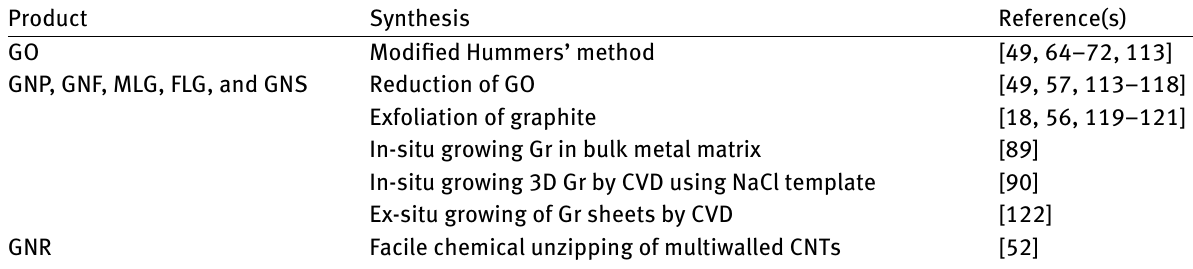
Table 2: Summary of Synthesized Gr and its Derivatives in GRMMC Studies.